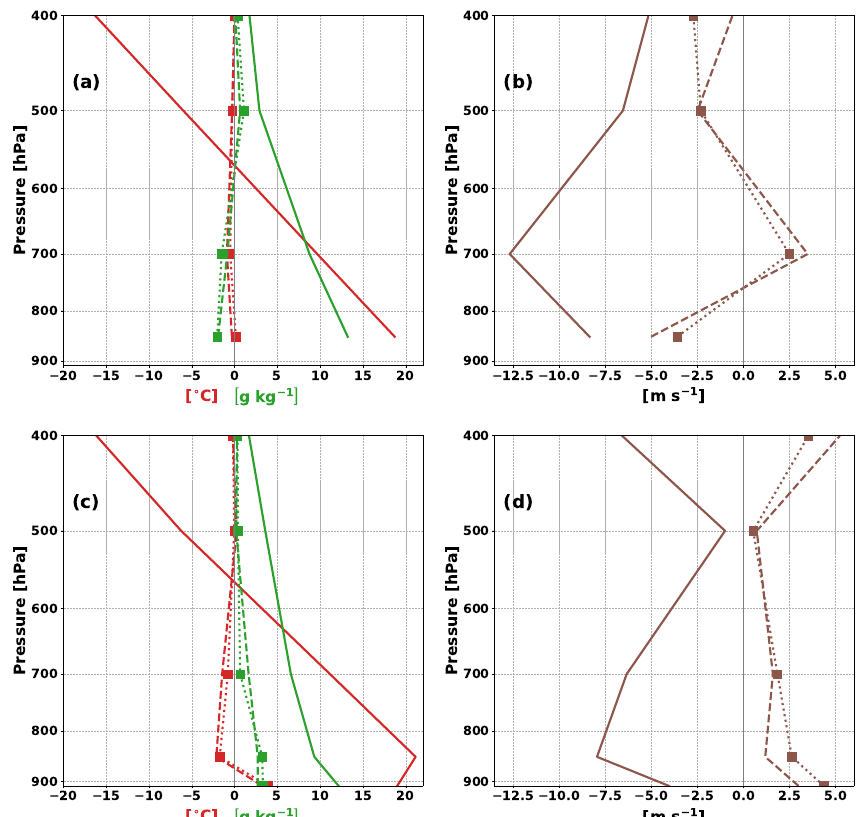
Figure 7. Daily mean vertical profiles of temperature ( ◦ C; red lines) and specific humidity (g kg − 1 ; green lines) ( a , c ) and zonal wind (m s − 1 ) ( b , d ) for 11 July and 1 September 2004, respectively. Solid lines represent radiosonde data, while the GrMRF (KFGS) D3 simulation data minus observations are shown with dashed lines (dotted lines with square